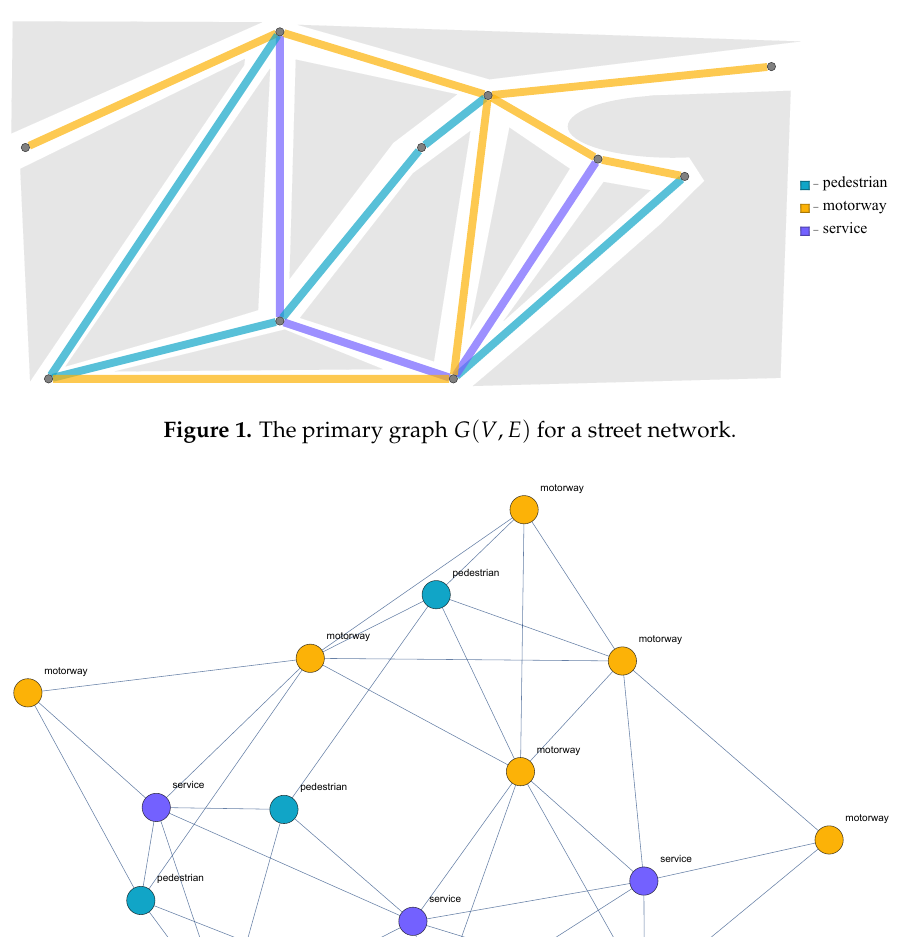
Figure 1. The primary graph G ( V , E ) for a street network